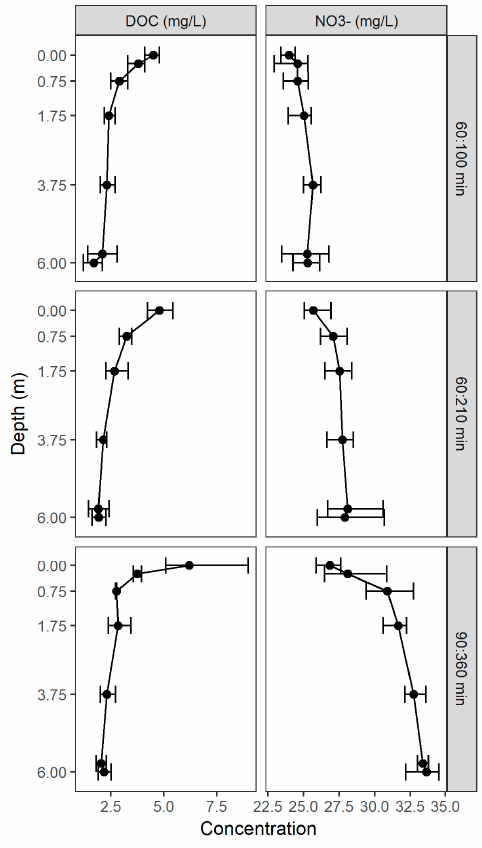
Figure 3. Depth profiles of dissolved organic carbon (DOC) and nitrate (NO3-) concentrations (mg/L) in the 6 m soil column for three different scenarios. Values are averages of six evaluated infiltration cycles per scenario; minimum and maximum values are indicated by error bars.